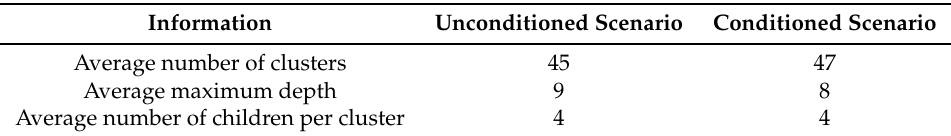
Table 5. Information about the network